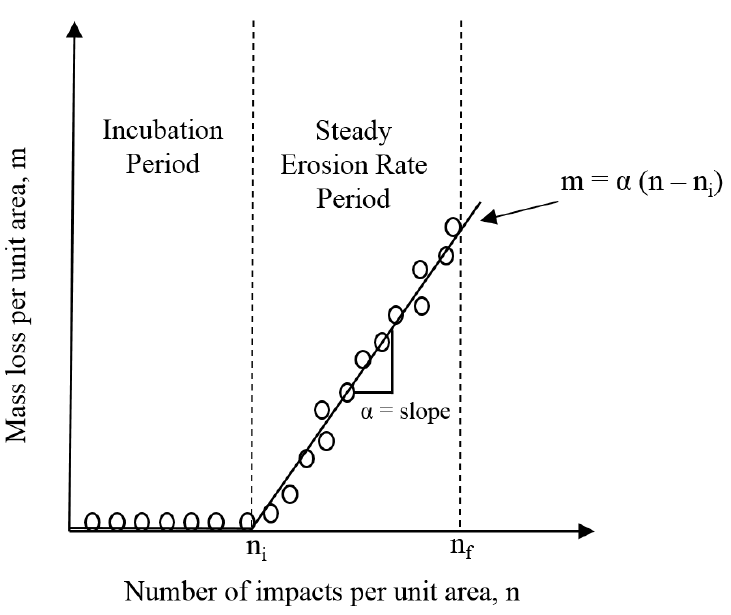
Figure 17. Schematic of Springer’s solution model. Redrawn from [134].